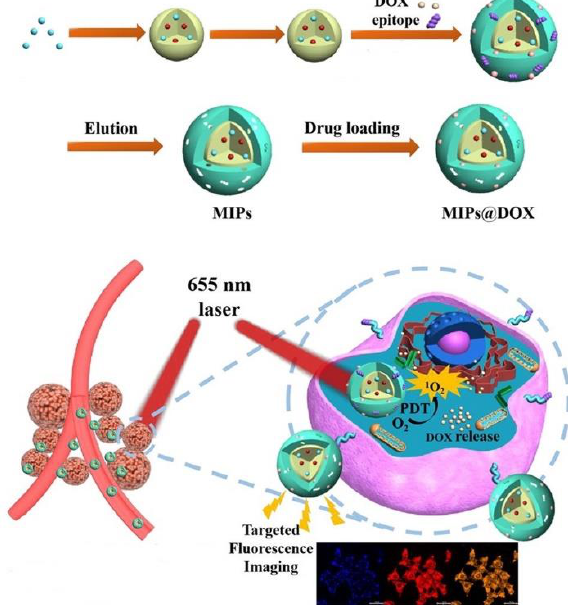
Figure 11. Schematic illustration for the preparation of luminescent MIP@DOX and its targeted chemo-photodynamic synergistic cancer therapy. Adapted with permission [140]. Copyright 2020, American Chemical Society.